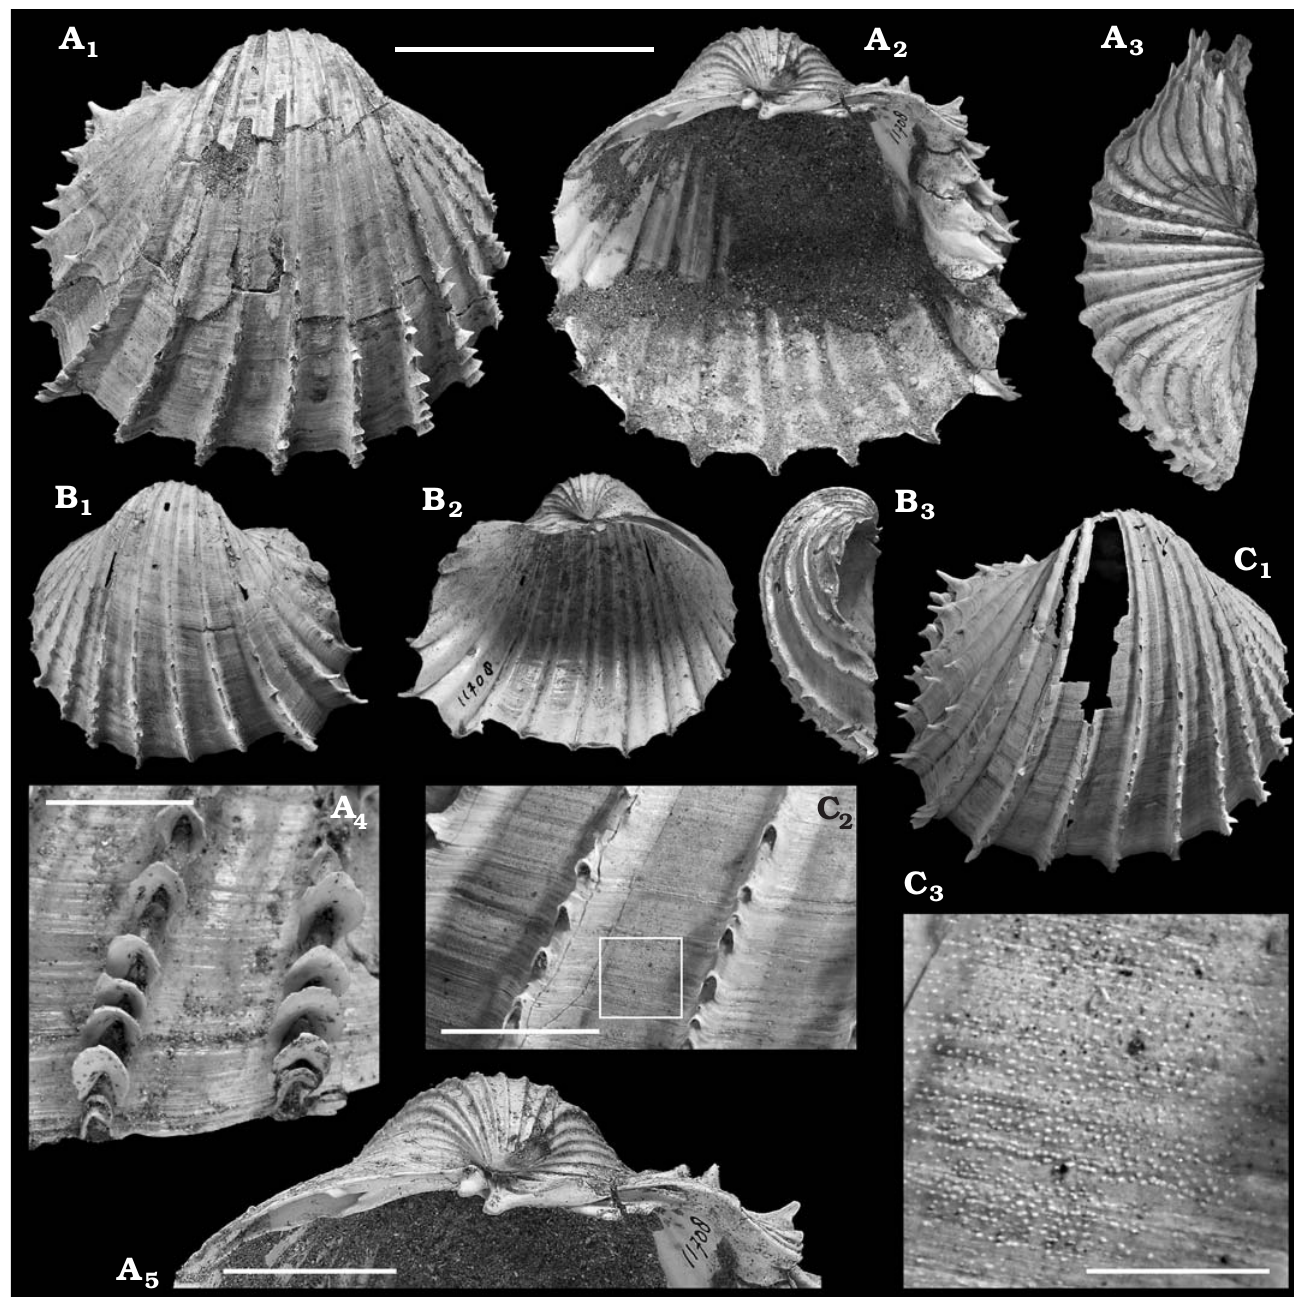
Fig. 15. Cardiid bivalve Procardium magnei sp. nov. from early Burdigalian (Miocene) of Saucats, “La Coquillière”, France. A . Holotype, PH 11708, external (A 1 ), internal (A 2 ), and umbonal (A 3 ) views, details of sculpture (A 4 ) and right hinge (A 5 ). B . Paratype, PH 63240, external (B 1 ), internal (B 2 ), and posterior (B 3 ) views. C . Paratype, RGM.794098, external view (C 1 ), detail of sculpture (C 2 ) and microsculpture (C 3 ). Scale bars: A 1 –A 3 , B, C 1 , 50 mm; A 5 , C 2 , 20 mm; A 4 , 10 mm; C 3 , 5